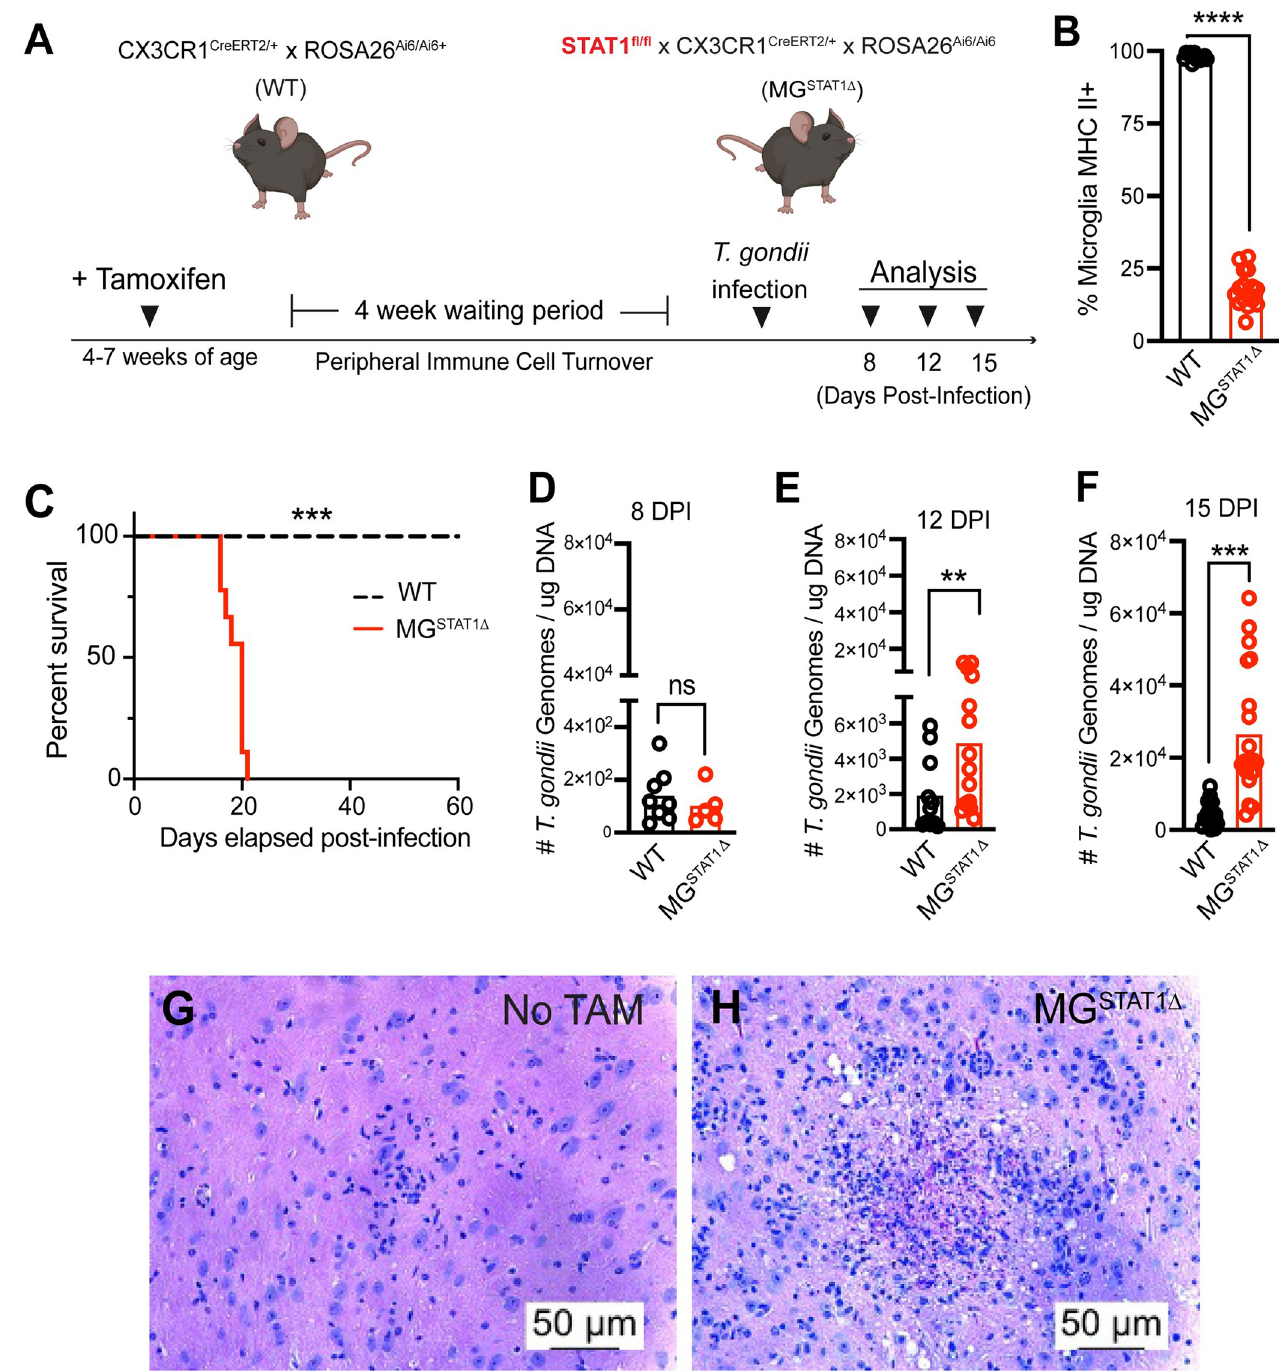
Fig 2. Mice with STAT1-deficient microglia succumb to fatal toxoplasmic encephalitis. (A-F) Tamoxifen-treated CX3CR1 CreERT2/+ x ROSA26 Ai6/Ai6 (WT) and STAT1 fl/fl x CX3CR1 CreERT2/+ x ROSA26 Ai6/Ai6 (MG STAT1 Δ ) mice were intraperitoneally infected with 10 cysts of the Me49 strain of T . gondii and analyzed at 8, 12, and 15 DPI. (A) Schematic for generating WT and MG STAT1 Δ mice. (B) Flow cytometric quantification of microglial MHC II expression at 12 DPI, as a functional readout for STAT1 excision. (C) Animal survival curve of WT and MG STAT1 Δ following T . gondii challenge. (D – F) qPCR analysis of T . gondii brain parasite burden quantified by qPCR analysis of homogenized brain tissue at 8- (D) , 12- (E) , and 15- (F) DPI. ( G, H ) Representative brain histopathology observed via H&E staining in litter-mate vehicle (G) or tamoxifen-treated MG STAT1 Δ mice at 15 DPI. ns = not significant, �� = p < 0.01, ��� = p < 0.001, ���� = p < 10 -4 . Statistical significance was determined by two-way randomized block ANOVA (B, D-F) or Kaplan-Meier analysis with n = 12-16 mice per group from 4 experiments (B) , n = 6-9 mice per group from 2 experiments ( C ), n = 5-8 mice per group from 2 experiments (D) , n = 11-15 mice per group from 3 experiments (E) , and n = 18-20 mice per group from 4 experiments ( F ). Scale bar = 50 um.